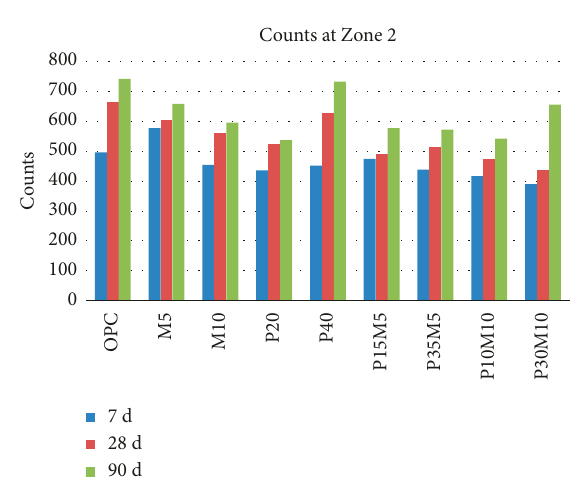
Counts at Zone 2